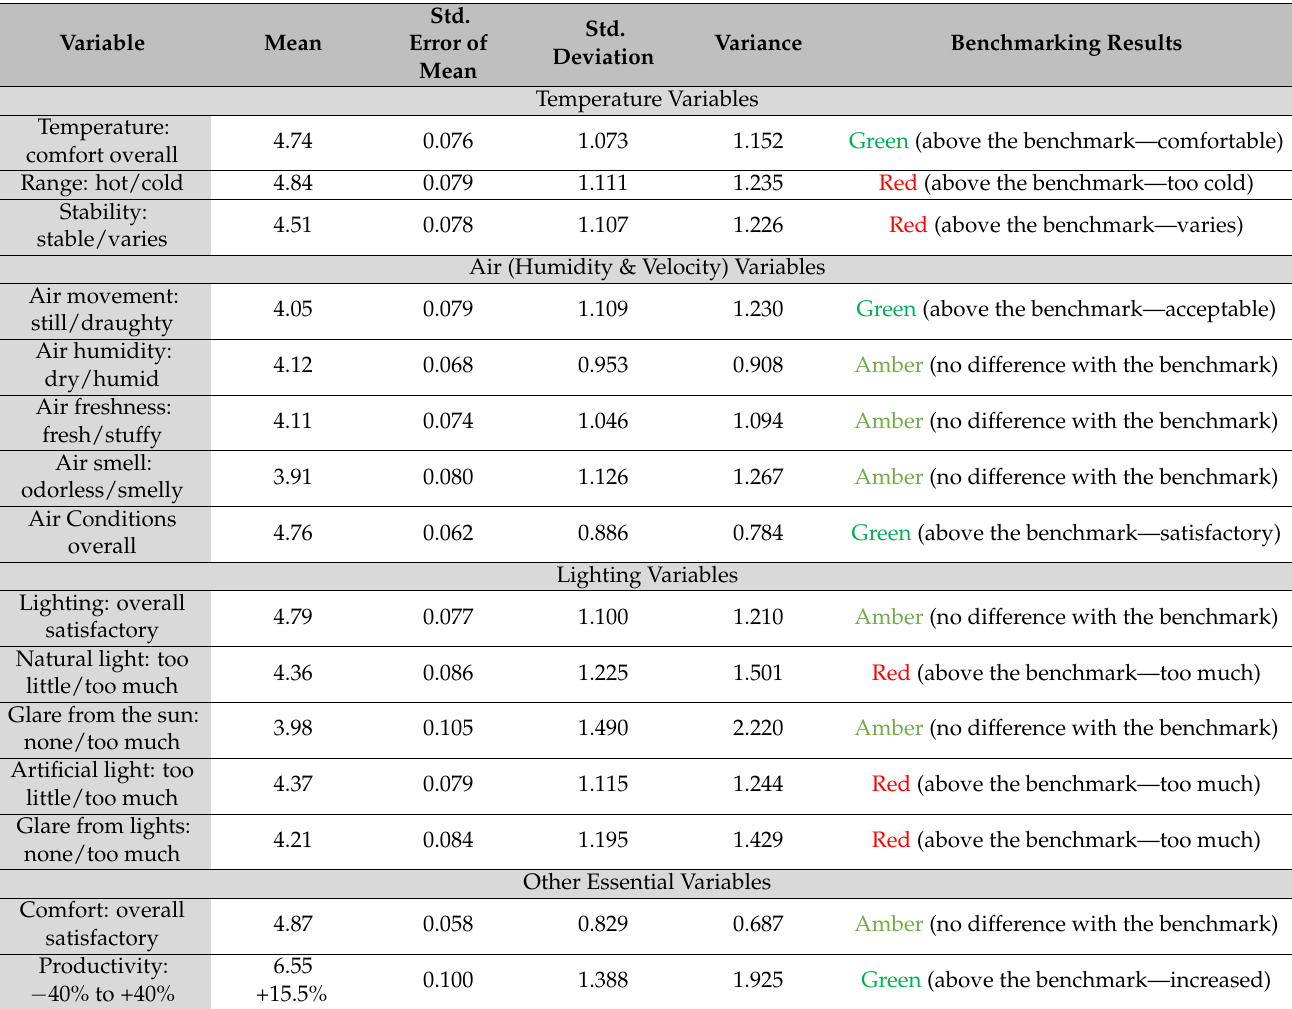
Table 3. The BUS survey results for all building